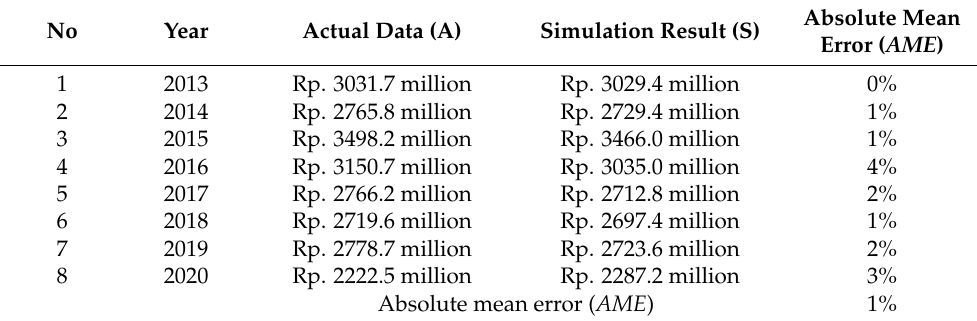
Table A3. Statistical Validation Using Absolute Mean